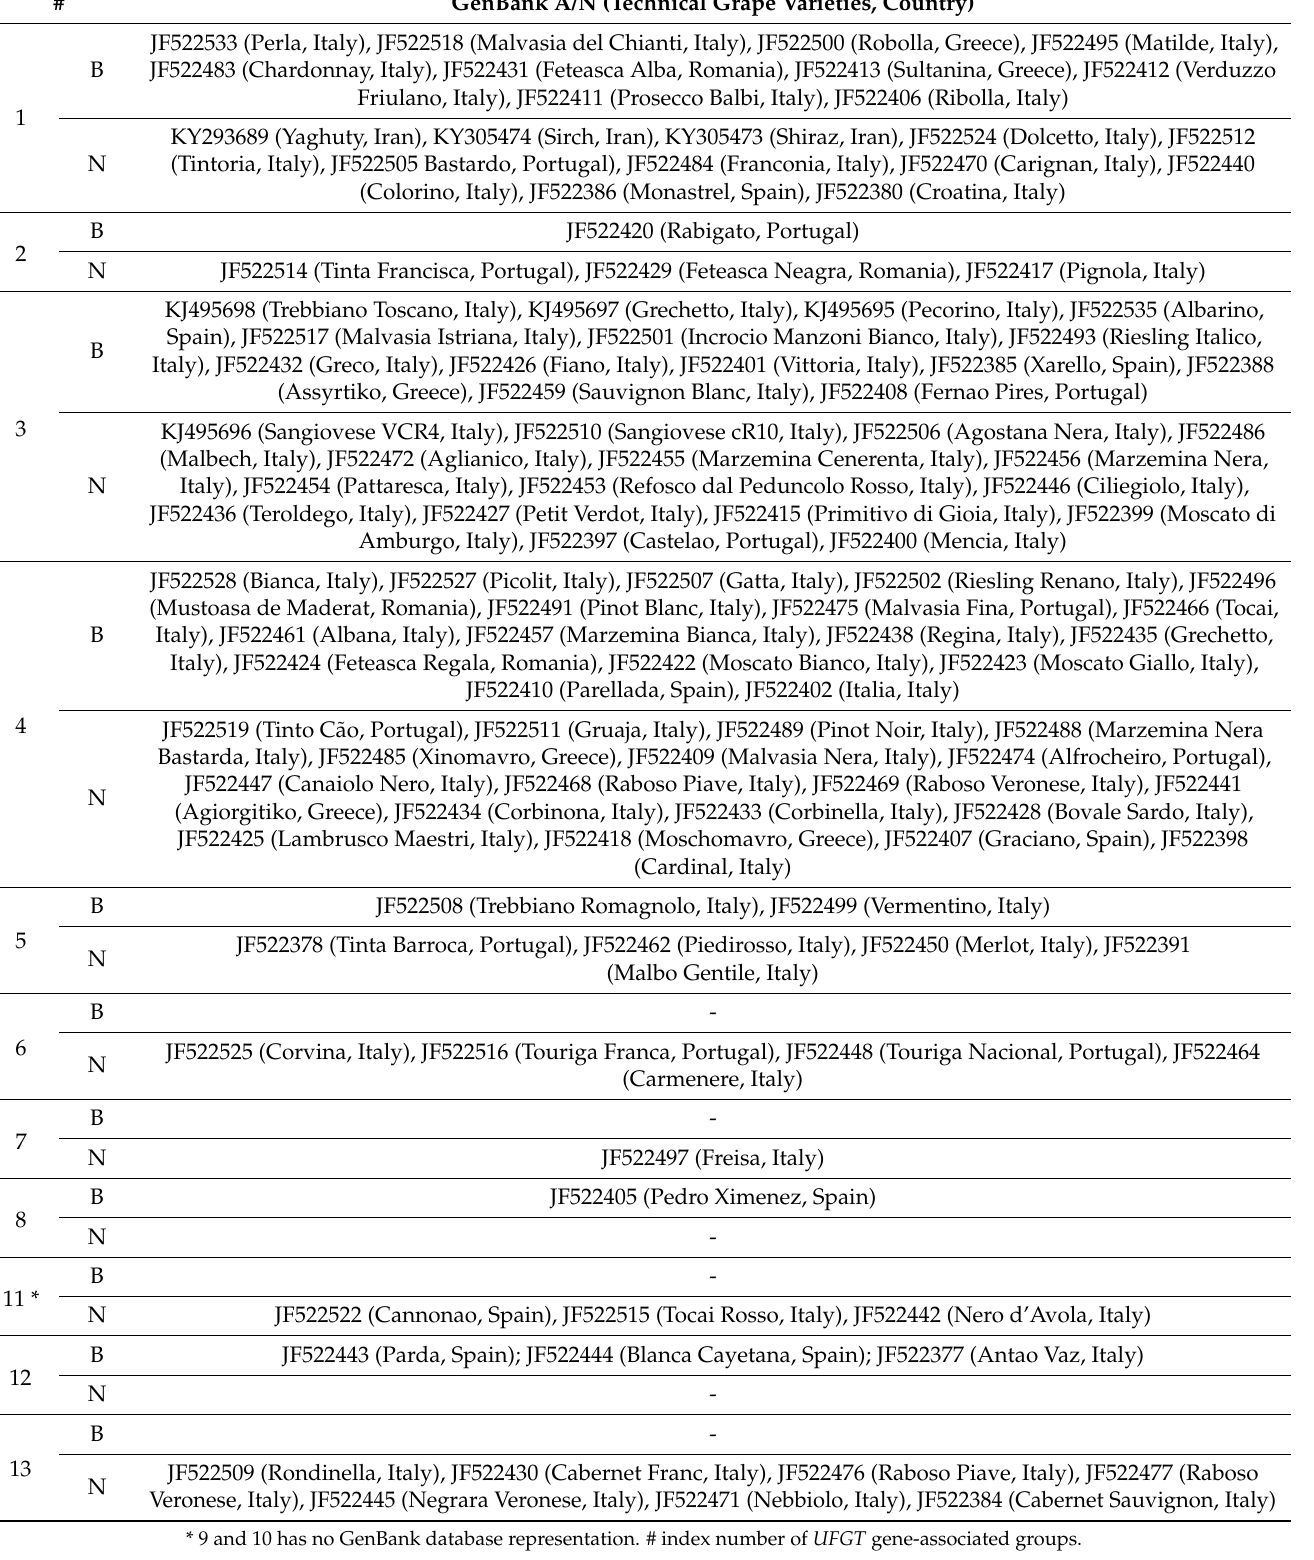
Table 6. Distribution of technical grape varieties according to UFGT gene-associated groups. GenBank A/N (Technical Grape Varieties,